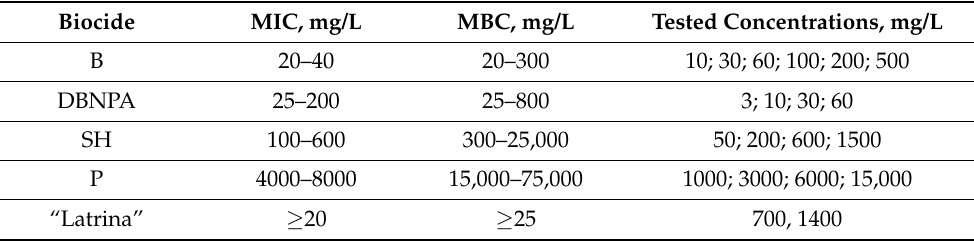
Table 6. Ranges of MIC and MBC values of the studied biocides for test-microorganisms and their working concentrations for the treatment of FS.